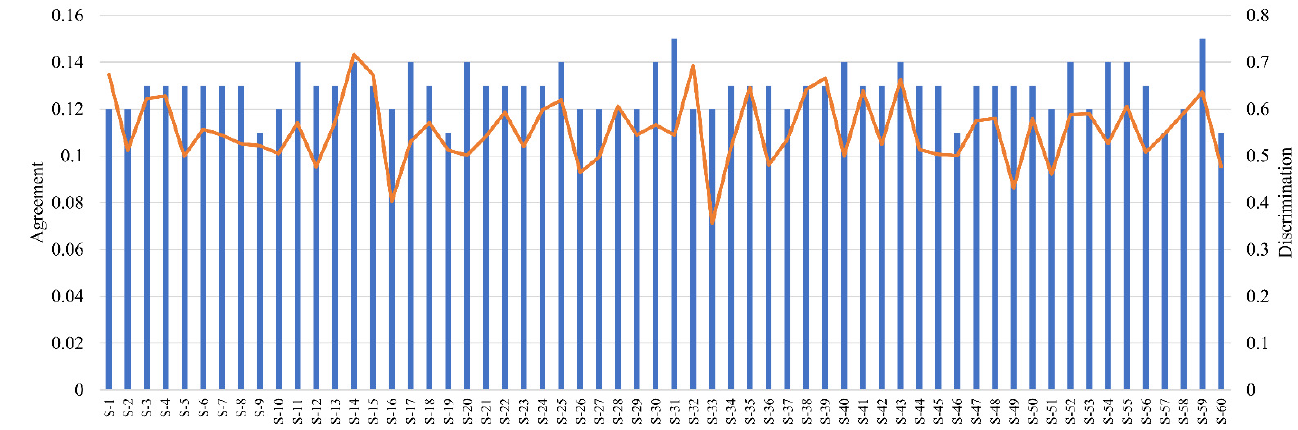
Figure 6. Agreement and discrimination ability of assessors from the flax biscuit case study. Agreement is presented by bars, while discrimination ability is presented by a line.